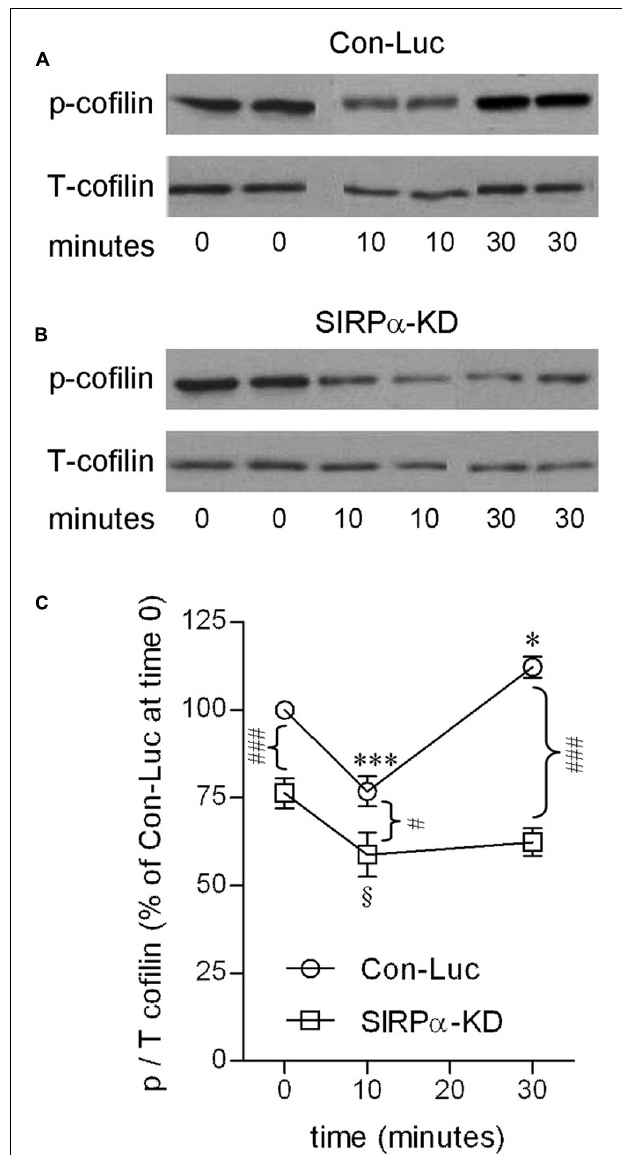
FIGURE 3 | Cofilin activation is transient in phagocytosing control microglia but continuous in phagocytosing SIRP α -KD microglia. Immunoblot analysis of phosphorylated and total cofilin-1 (p- andT-cofilin) in (A) control (Con-Luc) and (B) SIRP α -KD microglia before the onset of phagocytosis (time 0), and after 10 and 30 min of phagocytosis.The antibodies used for immunoblot analysis identify cofilin and cofilin-1 that is phosphorylated at S 3 . (C) Quantitation of the ratio p/T based on immunoblot analysis.The ratio p/T in non-phagocytosing Con-Luc microglia (i.e., at time 0) was defined 100%.Then, p/T in all other non-phagocytosing and phagocytosing microglia was calculated as percentage of p/T in non-phagocytosing Con-Luc microglia. Average values ± SEM of four to six experiments, each performed in duplicates, are given. Significance of differences between initial values at 0 min and those at 10 and 30 min by one way ANOVA and the Dunnet post test are * p < 0.05 and *** p < 0.001 for Con-Luc microglia and § p < 0.05 for SIRP α -KD microglia. Significance of difference between Con-Luc and SIRP α -KD microglia by two way ANOVA and the Bonferroni post test are # p < 0.05 and ### p < 0.001. Significance of difference between 10 and 30 min in Con-Luc microglia by one way ANOVA and theTukey’s post test is p < 0.001 (not